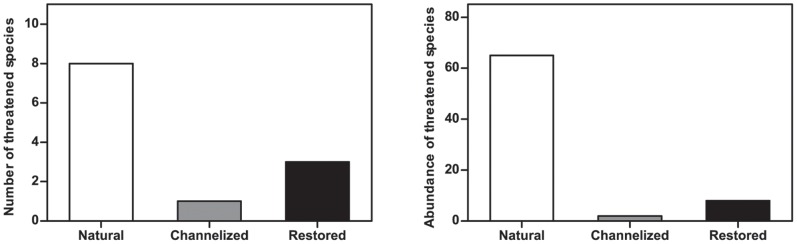
Number of threatened species and abundance according to stream type.In total, 75 individuals of 9 threatened species were found in the 18 streams.